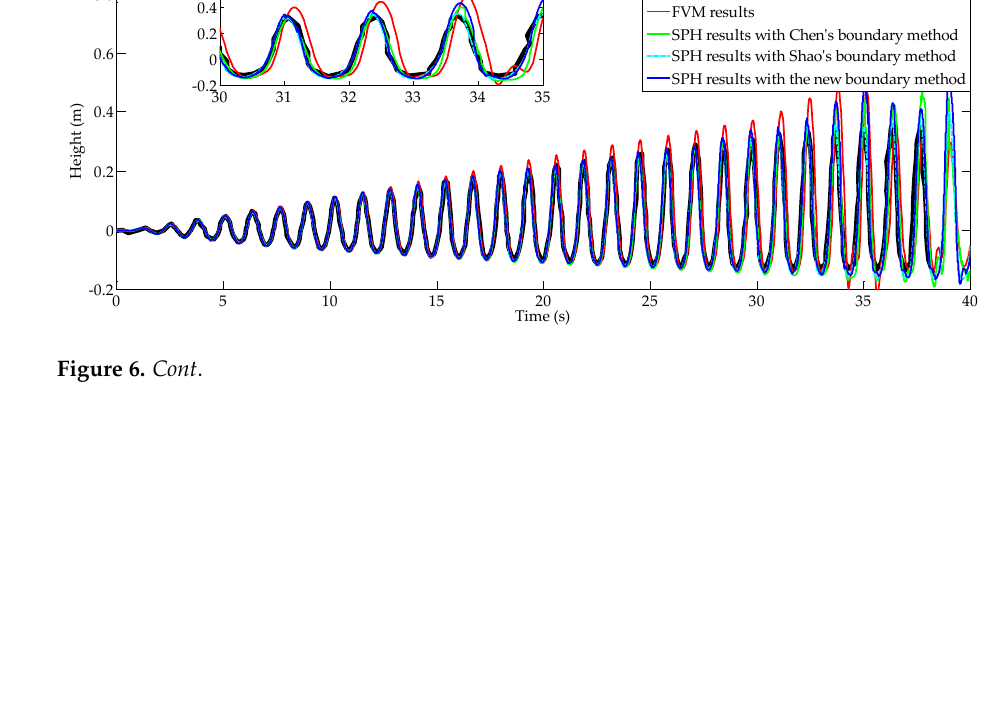
Experimental results FVM results SPH results with Chen's boundary method SPH results with Shao's boundary method SPH results with the new boundary method